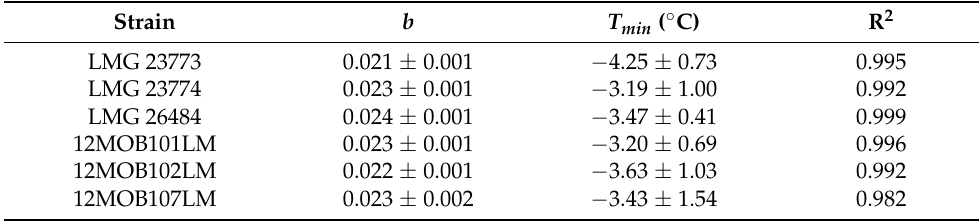
Table 2. Parameters ± standard errors of the secondary model [26] developed for the studied L. monocytogenes strains in smoked salmon p â t é